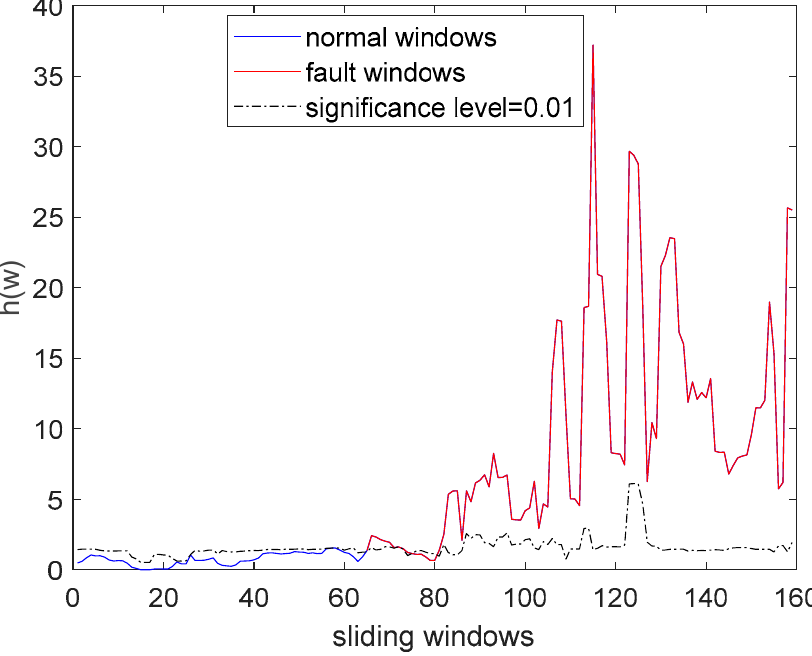
Figure 13. The detection result of the proposed method for the spread-spectrum transponder fault. Table 2. Comparison of the performance of three different methods at detecting the spread-spectrum transponder fault.